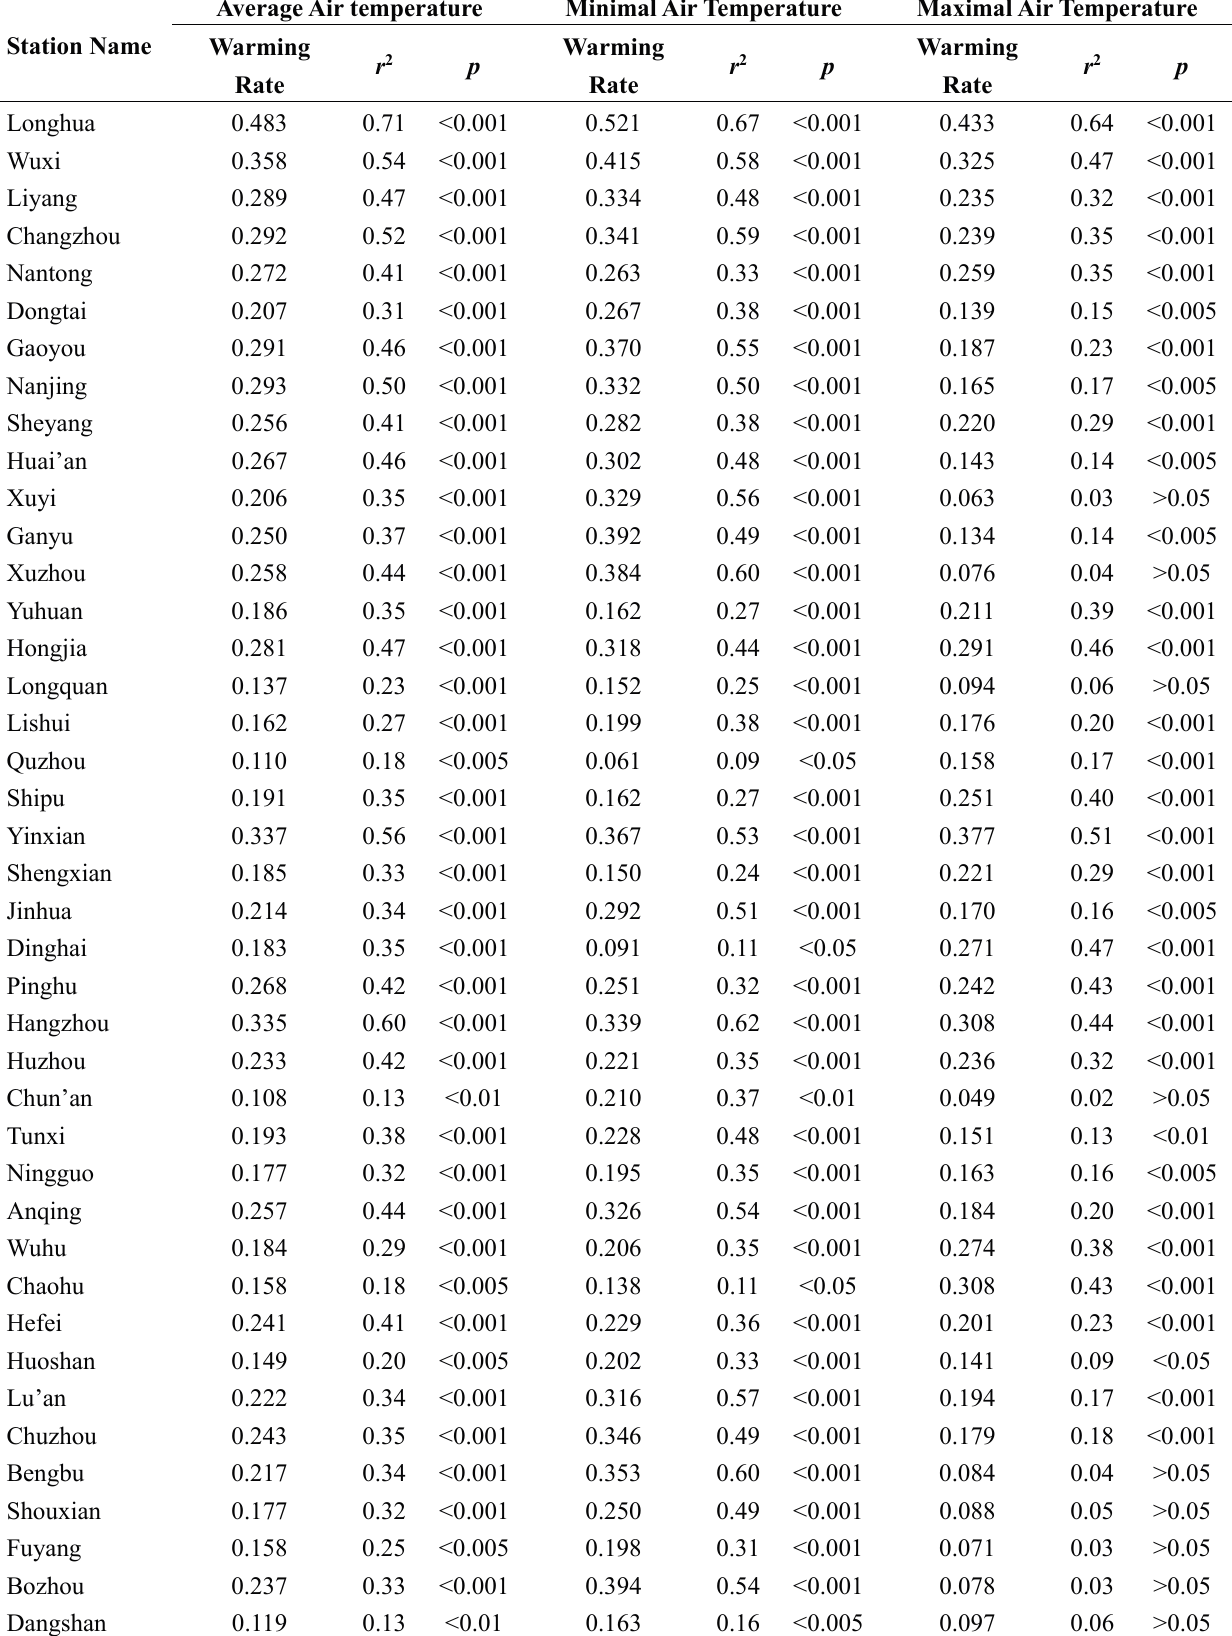
Table 2. Warming rate (°C/decade), determination coefficient ( r 2 ) and significance level ( p ) of the linear fit of the air temperature vs. year from 1957 to 2013 for all 41